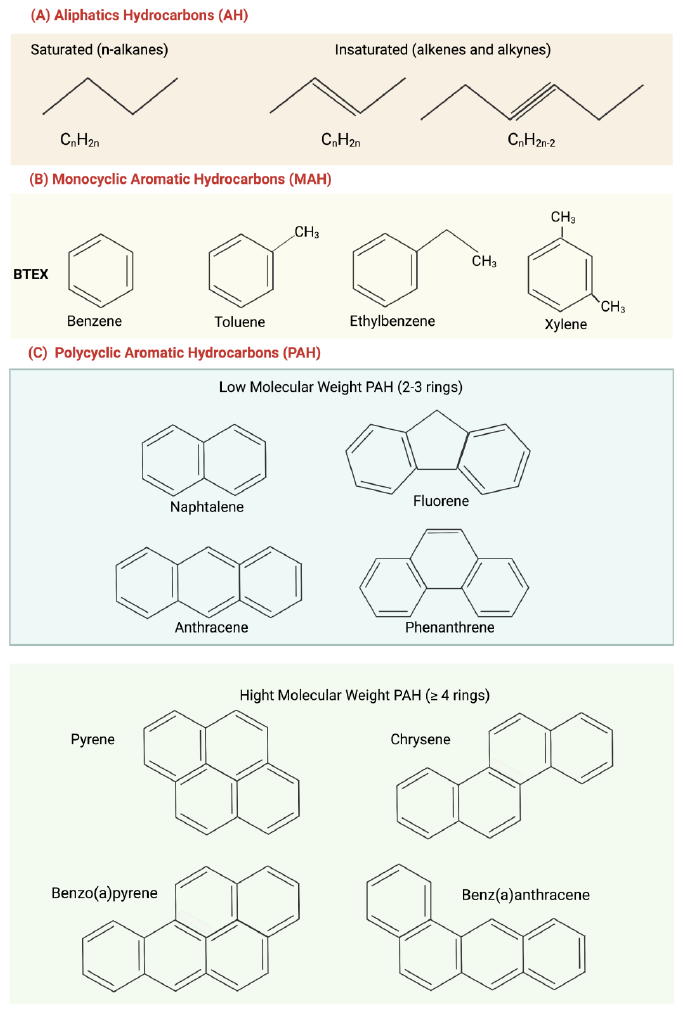
Figure 1. Structure of main hydrocarbons: ( A ) Aliphatic hydrocarbons (AH); ( B ) monocyclic aro- matic hydrocarbons (MAH); ( C ) polycyclic aromatic hydrocarbons (PAH), subdivided into low mo- lecular weight (in blue) and high molecular weight (in green).